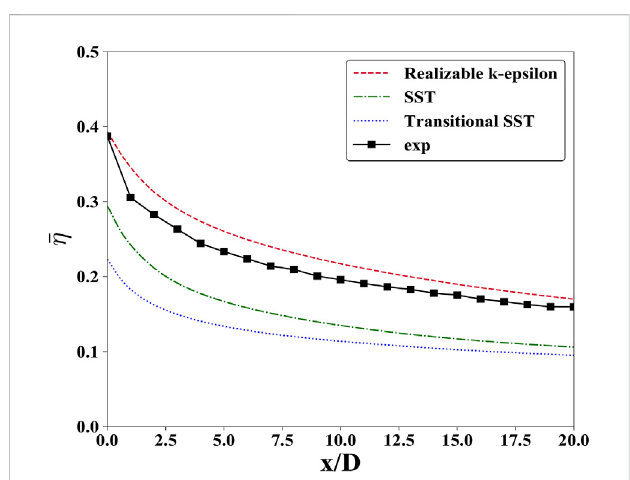
FIGURE 7 Numerical simulation results of the laterally averaged fi lm cooling effectiveness curves obtained from three selected turbulence models, together with the experimental results obtained from Li et al. (2018) and Wang et al. (2019).